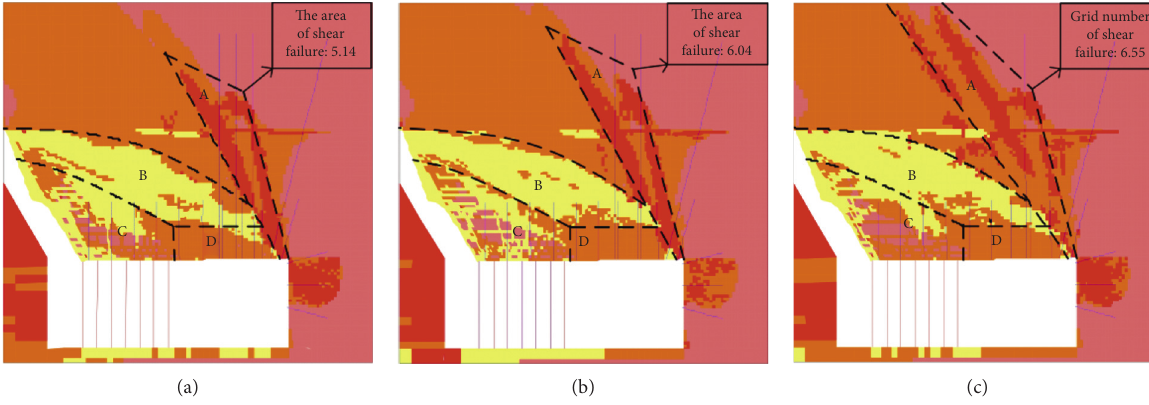
Figure 16: Cable space influencing the shear failure around removal area. (a) 0.6m. (b) 0.9m. (c) 1.2m.